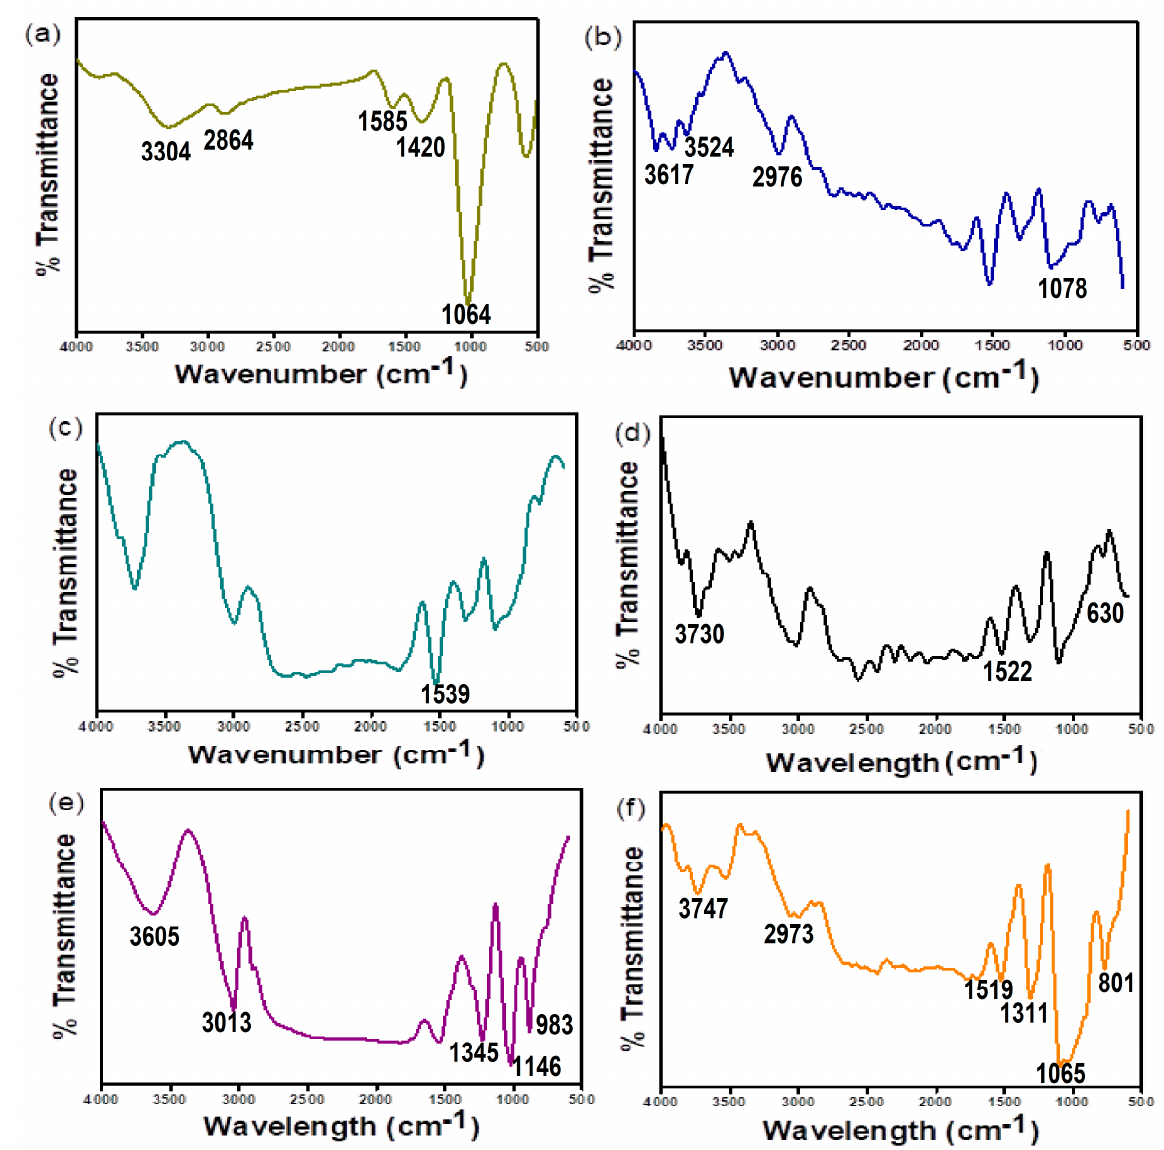
Figure 3. FT-IR spectra of ( a ) Chitosan ( b ) Polyvinyl alcohol ( c ) Graphite ( d ) Fe 3 O 4 nanoparticles ( e ) m-CGPA before adsorption ( f ) m-CGPA after adsorption of RO 16 dye.